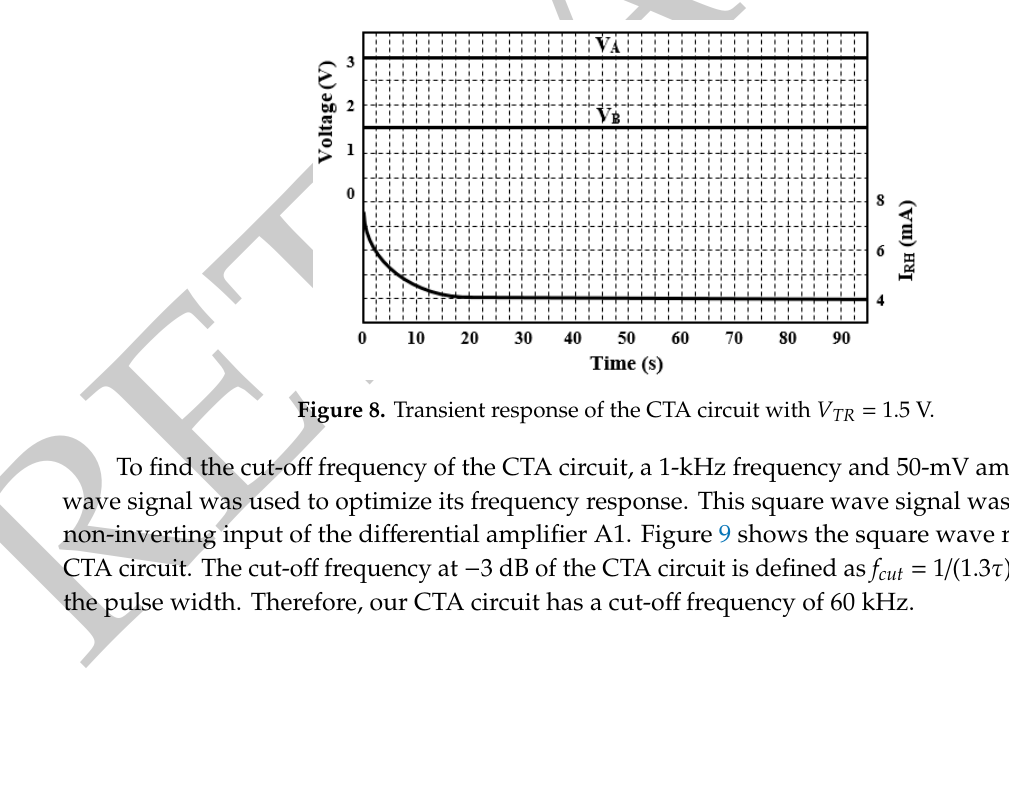
Figure 7. Measurement results for target voltage ( V TR ) = {0.5 V, 1 V, 1.5 V, 2 V}.